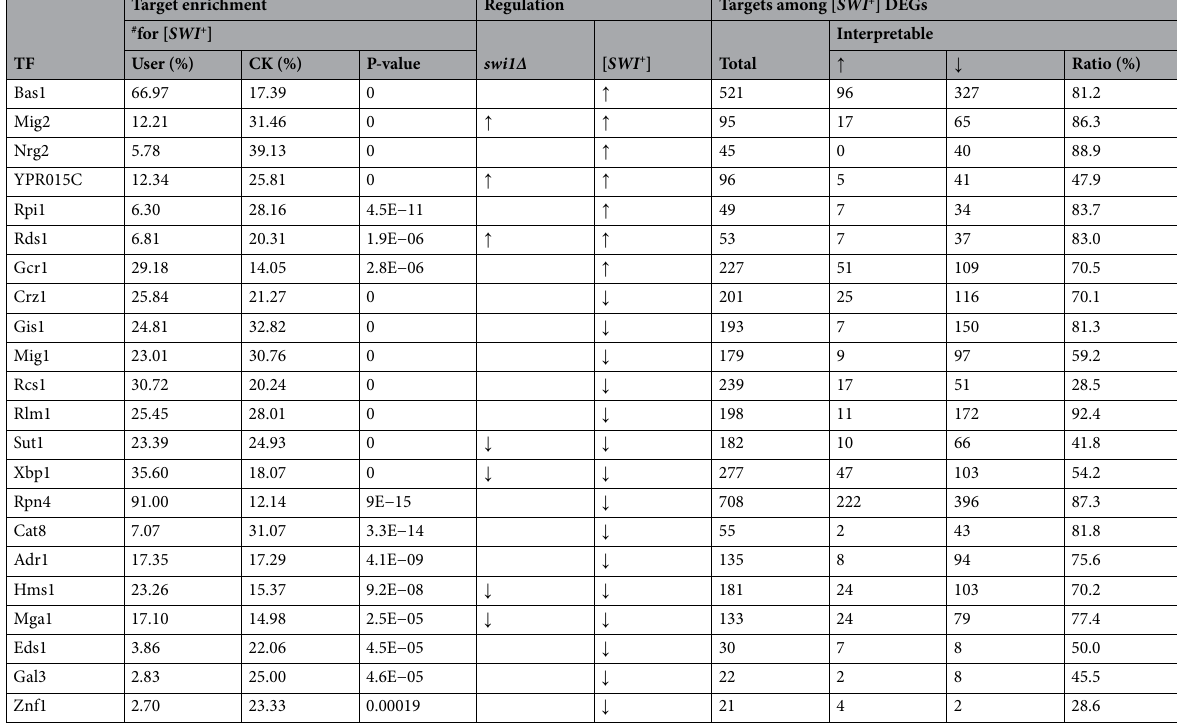
Table 1. 22 [ SWI + ]-regulated TFs and their targets. # User (%), ratio of the target number of a TF and the total number of [ SWI + ]-DEGs; CK (%), ratio between the number of targets found in [ SWI + ]-DEGs and the number of total targets of a TF from YEASTRACT. The TF/targets linkage is based on genetic data